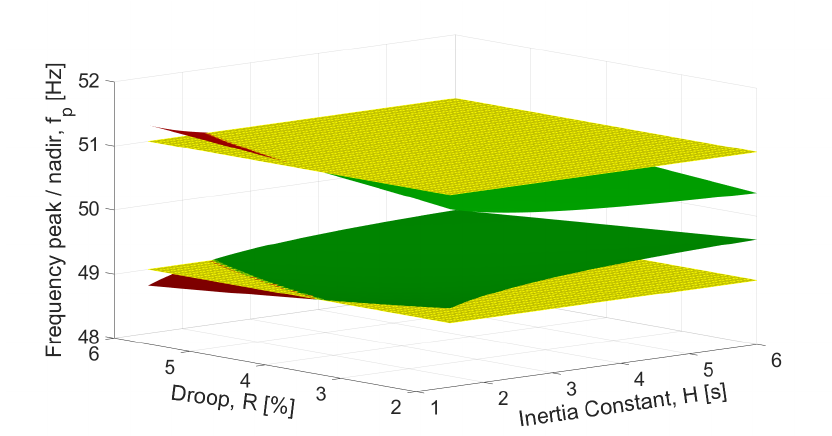
Figure 8. Impacts of R and H on f p for Cross-compound steam generator.